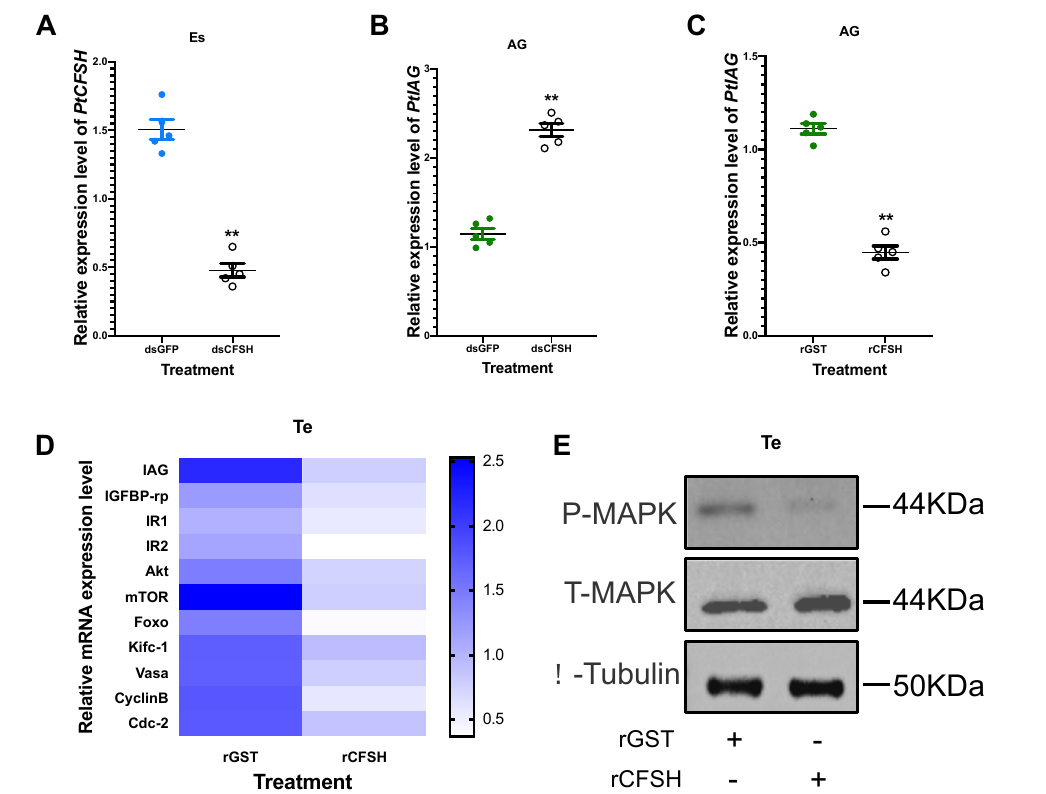
Figure 5. Effects of rPtCFSH and dsPtCFSH in vitro treatment on gene and protein expression of P. trituberculatus. ( A ) Interference efficiency of in vitro co-culture of the eyestalk and AG and treated with dsPtCFSH. The mRNA transcription of PtCFSH was significantly reduced in the eyestalk compared to dsGFP, with an interference efficiency of 71.4%. ** indicates acceptance p < 0.01. ( B ) Effect of in vitro co-culture of the eyestalk and AG and treated with dsPtCFSH on PtIAG . The expression of PtIAG was remarkably increased in the AG. ** indicates acceptance p < 0.01. ( C ) Effects of rPtCFSH in vitro treatment on PtIAG . qPCR results showed that IAG in AG was down-regulated dramatically after being subjected to PtCFSH . ** indicates acceptance p < 0.01. ( D ) Heat map of gene expression levels in the testis after rPtCFSH in vitro treatment. Different colors of the same tested gene between the experimental and control groups indicated significant differences. The darker the color in the heat map, the higher the relative expression of the tested genes and vice versa. ( E ) Changes in phos- phorylated-MAPK after rPtCFSH in vitro treatment of testis. Total-MAPK, β -tubulin as internal ref- erence protein. The scale bar is shown in the lower right corner. Vertical bars represent means ± SEM (n = 5). Significant differences among stages are indicated by different letter labels (one-way ANOVA followed by post hoc Tukey’s multiple group comparison p < 0.05).